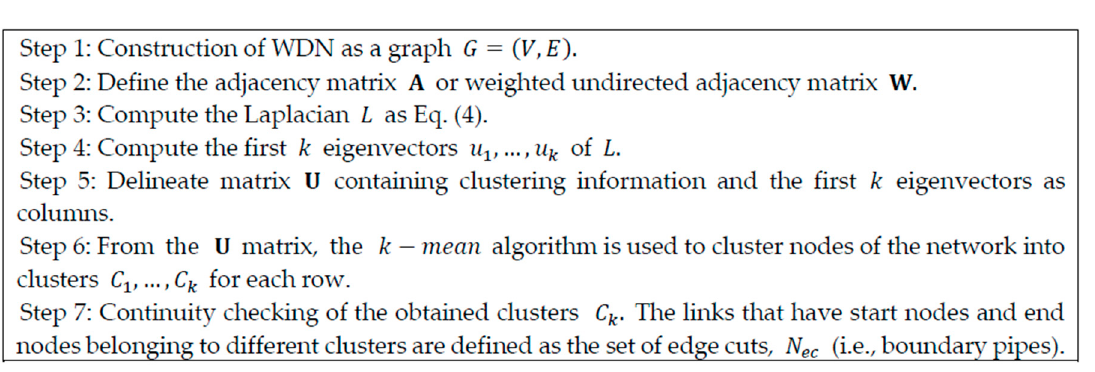
Figure 6. Flowchart of a non-normalized spectral clustering algorithm.